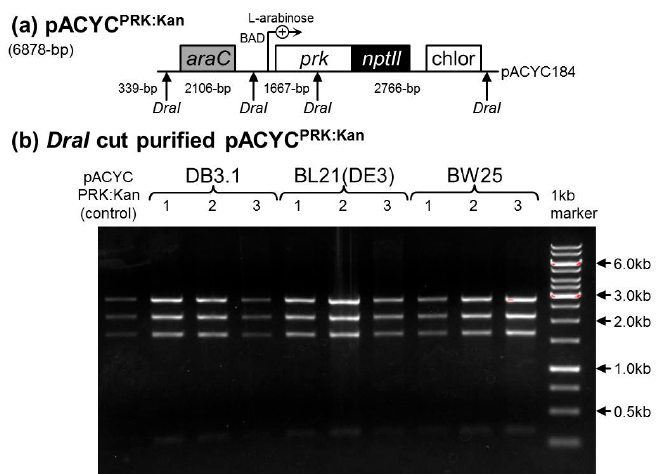
Figure A2. Restriction mapping of pACYC PRK:Kan . ( a ) The plasmid map and ( b ) DraI restriction mapping of the source pACYC PRK:Kan plasmid (control) and that purified from three separate colonies of the E. coli strains indicate that they survived growth on selective media containing 0.25% ( w / v ) l -Arabinose (Figure 4).